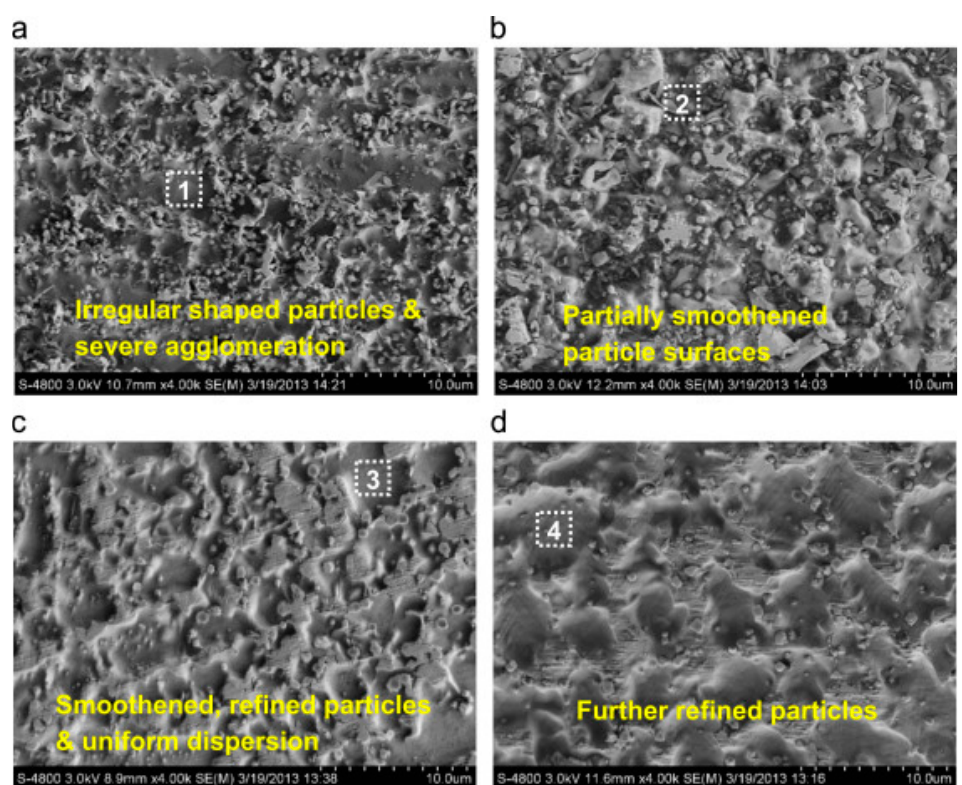
Figure 8. High-magnification SEM images showing composite structures of LMD-processed TiC/Inconel 625 parts using ( a ) P = 500 W, v = 900 mm/min, LEIPUL = 33 kJ/m; ( b ) P = 800 W, v = 900 mm/min, LEIPUL = 53 kJ/m; ( c ) P = 500 W, v = 300 mm/min, LEIPUL = 100 kJ/m; and ( d ) P = 800 W, v = 300 mm/min, LEIPUL = 160 kJ/m [67].